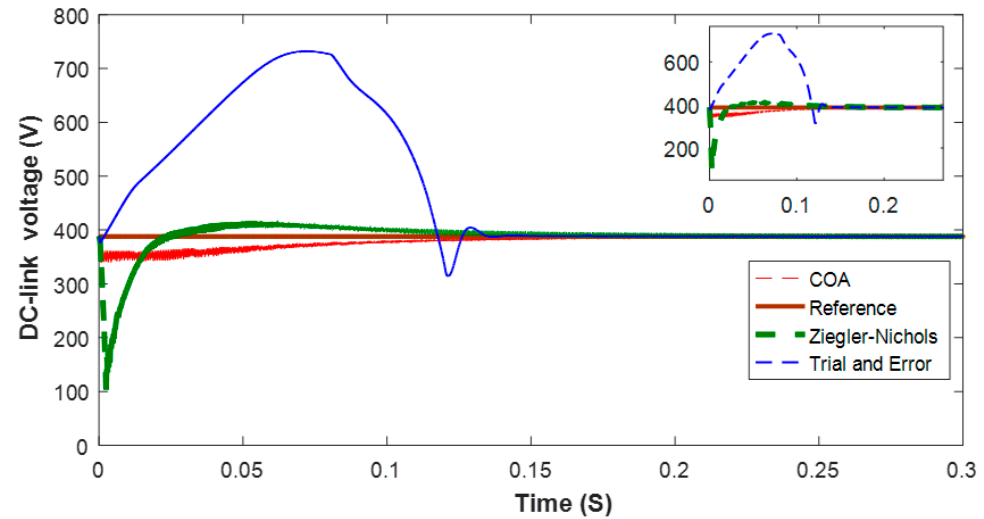
Figure 7. DC-link voltage under different methods. Table 2. Output performance under different methods.